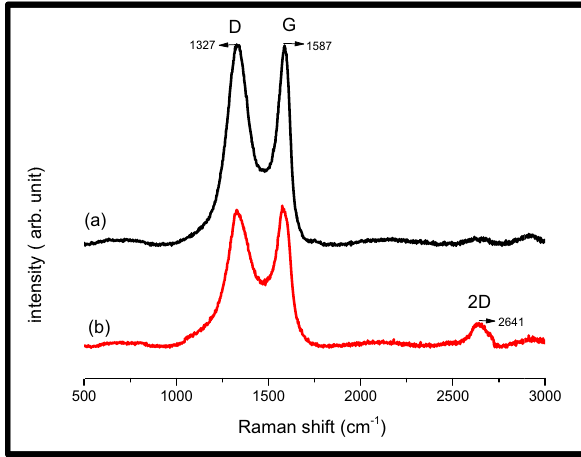
Figure 2: The Raman spectra of ( a ) GO1 and ( b ) GO2.